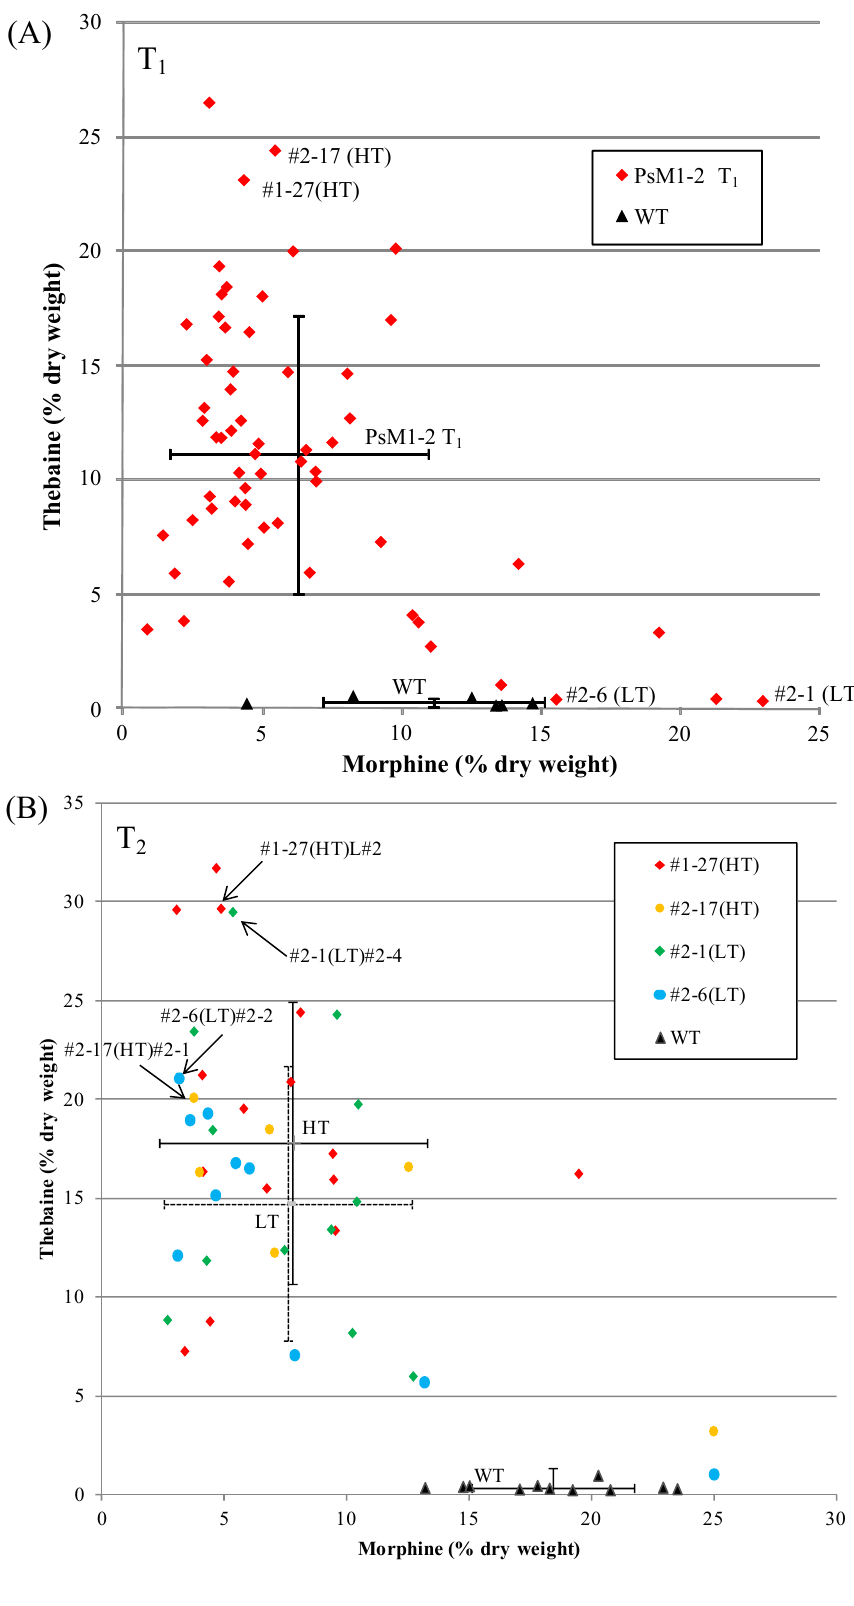
Figure 3. Alkaloid content in the latex from the soil-cultivated WT and PsM1-2 T nd: Not detected. Scatter diagram of the morphine (x-axis) and thebaine (y-axis) contents in ( A ) PsM1-2 T plants (n = 60) and WT plants (n = 6), ( B ) four lines of PsM1-2 T 1 and WT plants, and ( C ) two lines of PsM1-2 T plants and WT 3